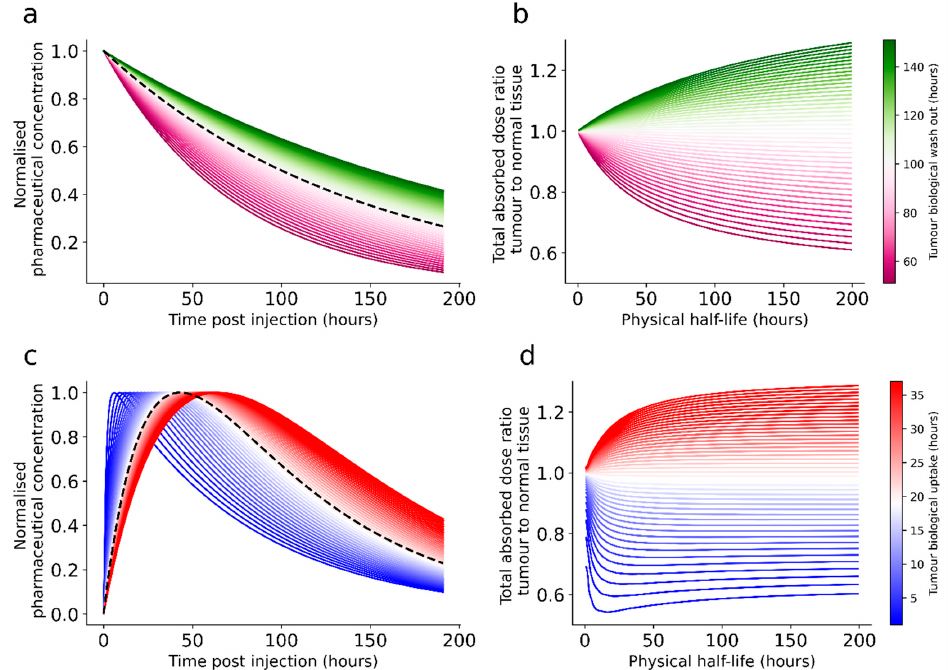
Figure 5. The figure illustrates theoretical situations that involve biological uptake and clearance of a radiopharmaceutical in a normal organ and tumours ( a , c ) and the differences in absorbed dose ratios that can be expected by selecting radionuclides with various half-lives for each ( b , d ). Two different types of kinetics are illustrated. In both scenarios, the normal tissue kinetics (illustrated with a dashed black line) are kept fixed and the tumour kinetics are varied. In the first situation, illustrated in panel ( a ), with the corresponding ratios in panel ( b ), an instantaneous uptake and a mono-exponential elimination is assumed for both tumour and normal tissue. The initial amount of radiopharmaceutical per tissue is set identical for both normal organ and tumours. The tumour-curves have been colour-graded according to the biological half-life, where white is equal to the normal tissue elimination (here, 100 h), whereas more saturated green indicates a slower and saturated purple indicates a faster elimination compared to the normal tissue. In panel ( b ), the ratios between the total energy absorption between tumour and normal tissue for the different tumour eliminations have been plotted for a range of physical half-lives. In panel ( c ), a different situation with bi-exponential uptake and washout is illustrated. Here, the rate of wash-out is kept fixed, while the uptake phase is varied. Again, different theoretical tumours are shown in coloured whole lines, where more saturated blue is a faster uptake and more saturated red is a slower uptake, while the normal organ is represented by a black dashed line. The curves here have been normalised to the same maximum amount of radiopharmaceutical per tissue. In panel ( d ), the absorbed dose ratios between the tumours and the normal organ are plotted over a range of physical half-lives for this scenario. In general, the activity in the different tissues, and, hence, the absorbed dose rate, is continually changing after administration of the radiopharmaceutical. Most radiothera- peuticals, especially those injected intravenously, will display an uptake and a washout phase. The rates and kinetics of the different phases vary between tissues. The absorbed dose deposited from activity within a tissue (the so-called self-dose) in radionuclide ther- apy is given by the total numbers of disintegrations occurring per mass multiplied by the